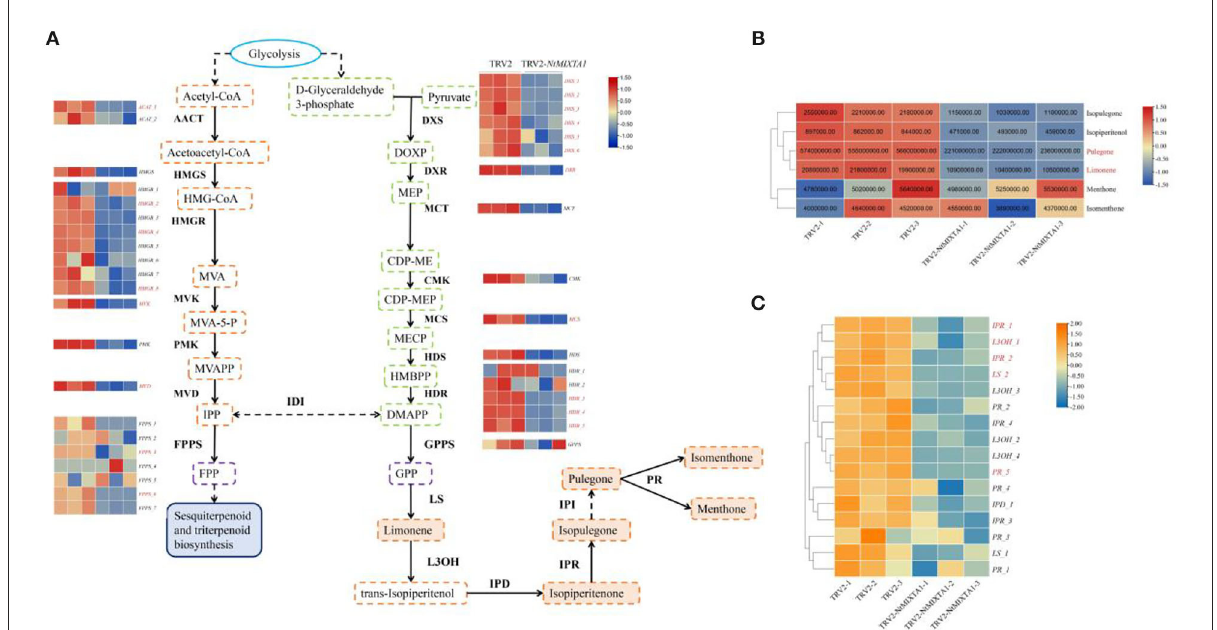
FIGURE6 Biosynthesis of menthane monoterpene and variations involving related genes and metabolites; (A) biosynthetic pathway of menthane monoterpene biosynthesis; (B) heatmap of menthane monoterpenes content; (C) heatmap of gene expression in menthane monoterpene biosynthesis. Enzyme abbreviations: AACT, acetyl-CoA C-acetyltransferase; HMGS, hydroxymethylglutaryl-CoA synthase; HMGR, hydroxymethylglutaryl-CoA reductase; MVK, mevalonate kinase; PMK, phosphomevalonate kinase; MVD, diphosphomevalonate